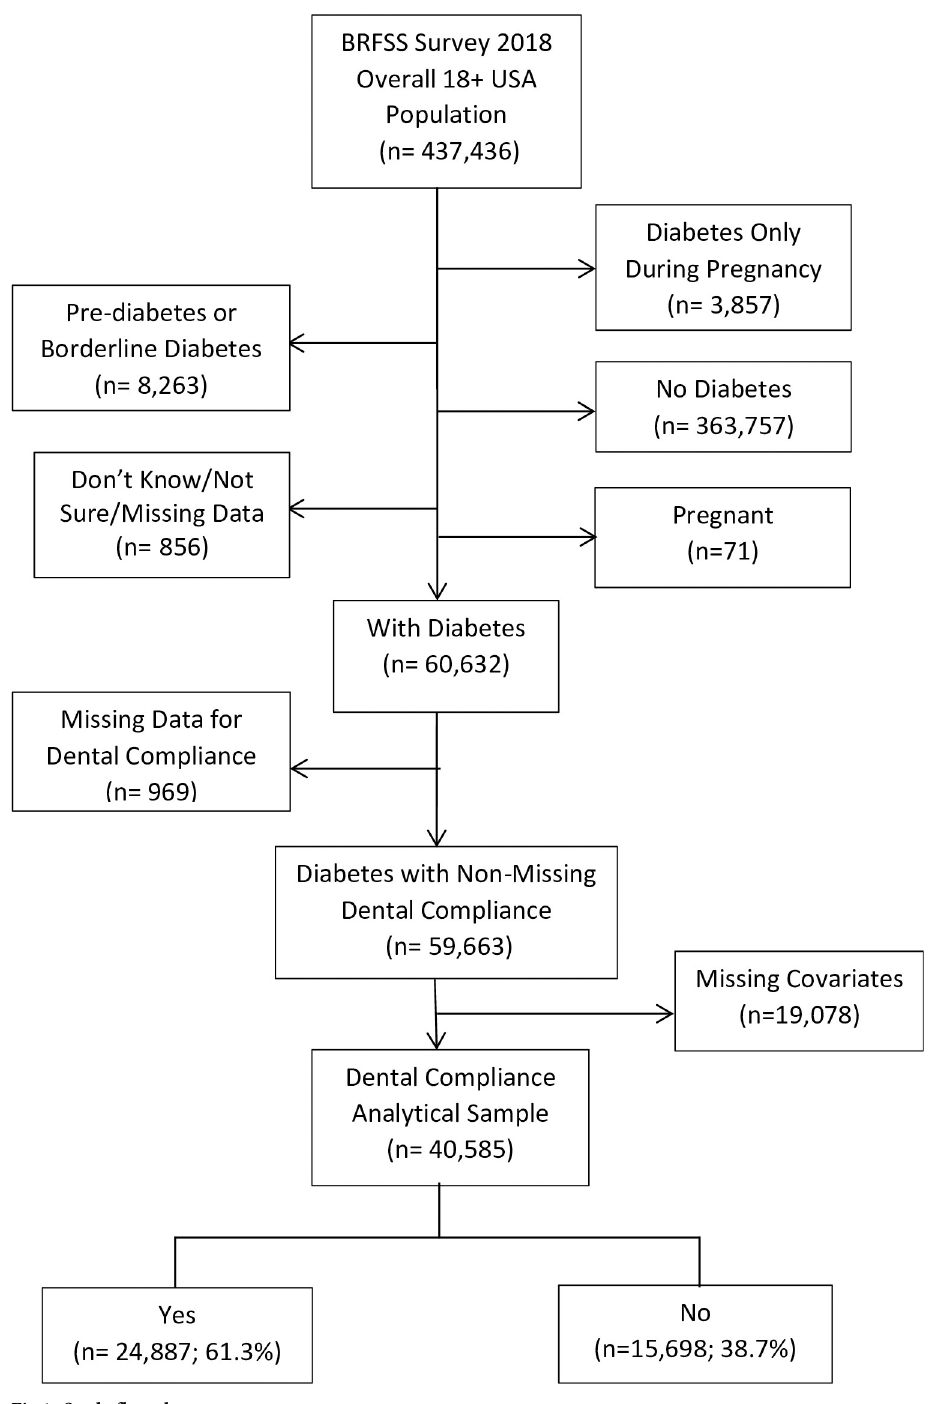
Fig 1. Study flow